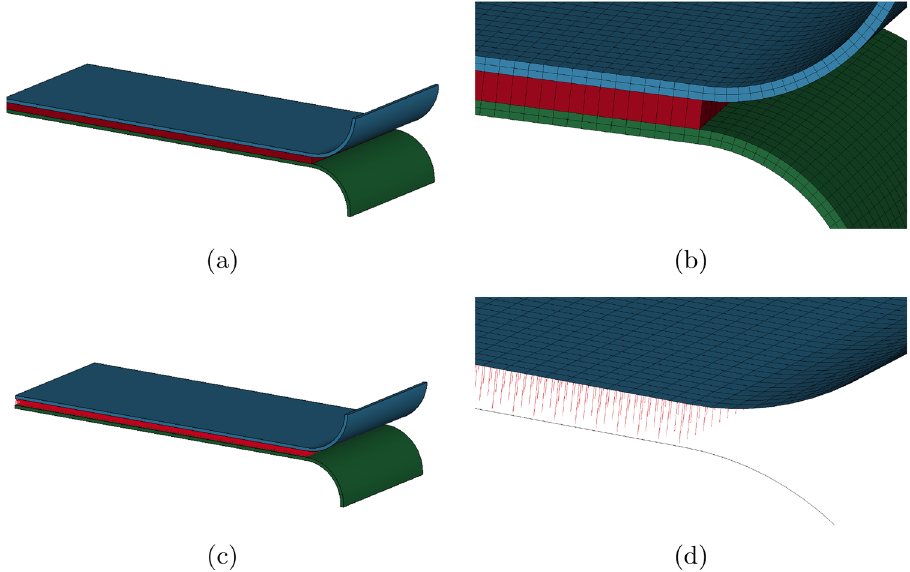
d , a discrete approach is used where the core is modeled using beam elements